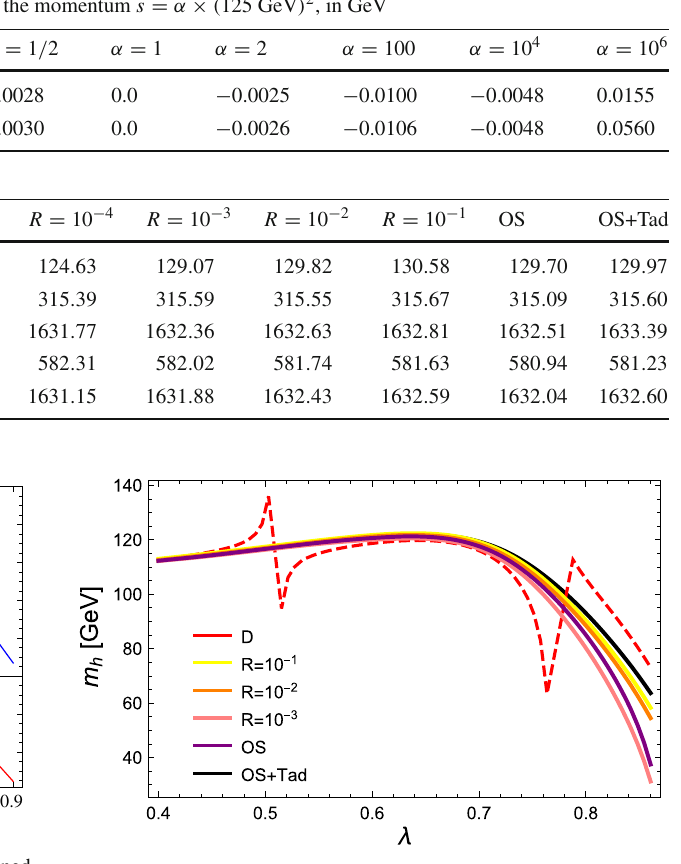
Fig. 3 The lightest Higgs mass at the two-loop level for the parameter point defined by Eq. (4.2) for different methods to regulate the two-loop corrections of λ is shown in Fig. 2. One can see that for λ (cid:8) 0 . 5 , 0 .